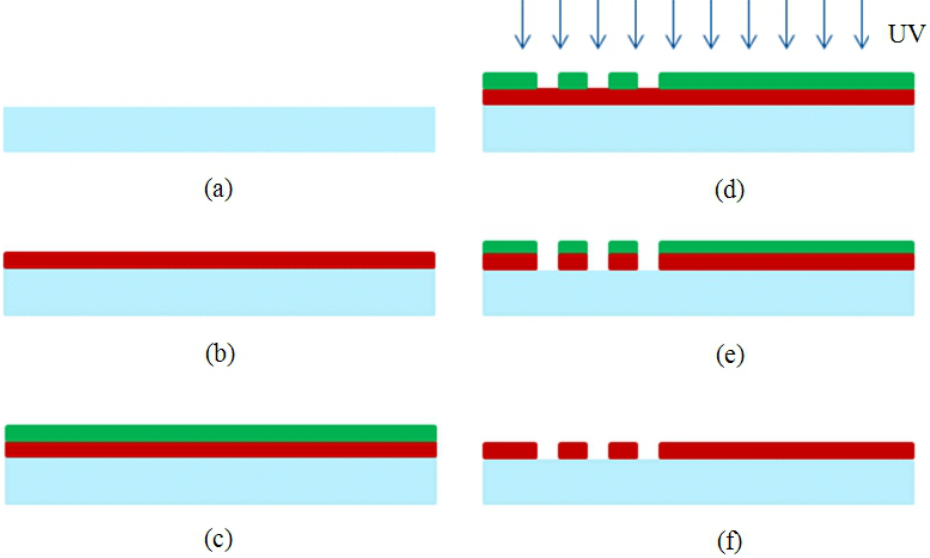
Figure 2. Overview of sensor fabrication: ( a ) ultrasound cleaning; ( b ) chromium deposition; ( c ) photoresist spinning; ( d ) exposure; ( e ) wet etching of chrome; ( f ) photoresist stripping.